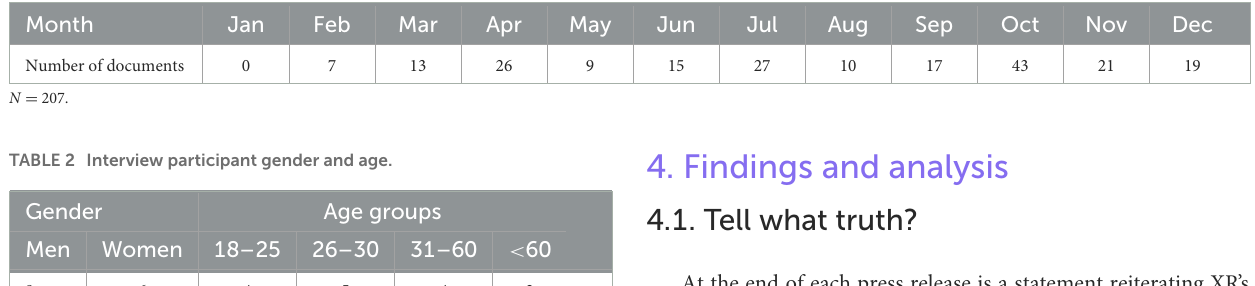
TABLE 1 Number of press releases per month in 2019.